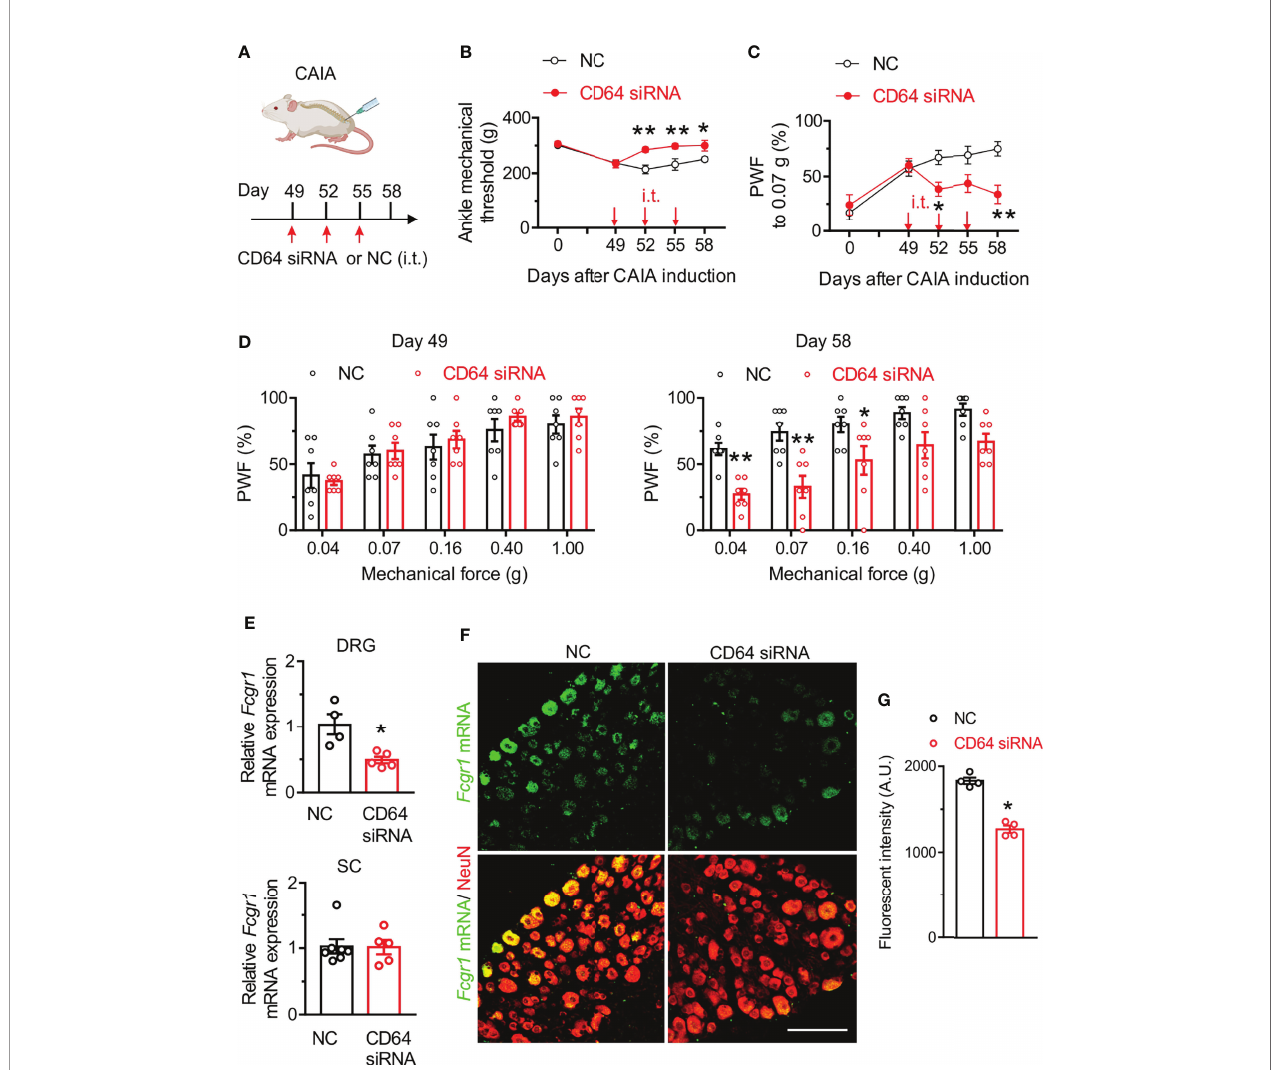
FIGURE 4 | CD64 siRNA knockdown in the DRG after resolution of joint in fl ammation alleviates persistent pain in the CAIA model. (A) Experimental schematic showing intrathecal (i.t.) administration protocol of CD64 siRNA (2 µg; 10 µl) or a negative control (NC; 2 µg; 10 µl) in mice subjected to CAIA. Pain-like behaviors were evaluated 3 days after each injection. (B, C) Time course of mechanical threshold in the ankle (B) , paw withdrawal frequency (PWF) in response to 0.07 g force (C) in the hind paw in NC- and CD64 siRNA- treated mice with CAIA. n = 7 mice per group; *p < 0.05, **p < 0.01 versus NC; two-way repeated measures ANOVA followed by Bonferroni correction. (D) Comparison of PWF in response to a series of mechanical forces (0.04, 0.07, 0.16, 0.40 and 1.0 g) in the hind paw of mice on days 49 and 58 after CAIA induction between NC- and CD64 siRNA-treated mice. n = 7 mice per group. *p < 0.05, **p< 0.01 versus NC, two-way repeated measures ANOVA followed by Bonferroni correction. (E) qPCR analysis of Fcgr1 mRNA expression in L3-L5 DRGs (n = 4-5 mice per group) and spinal cord (SC; n = 5-7 mice per group) in NC and CD64 siRAN treated mice on day 58 after CAIA induction. *p < 0.05 versus NC; unpaired Student ’ s t test. (F) Representative L4 DRG ISH image for Fcgr1 mRNA signal and immunostaining for NeuN. Scale bar: 100 µm. (G) Quanti fi cation of Fcgr1 mRNA expression in DRG neurons of either NC or CD64 siRNA-treated mice. n = 4 mice per group; *p < 0.05 versus NC; unpaired Student ’ s t